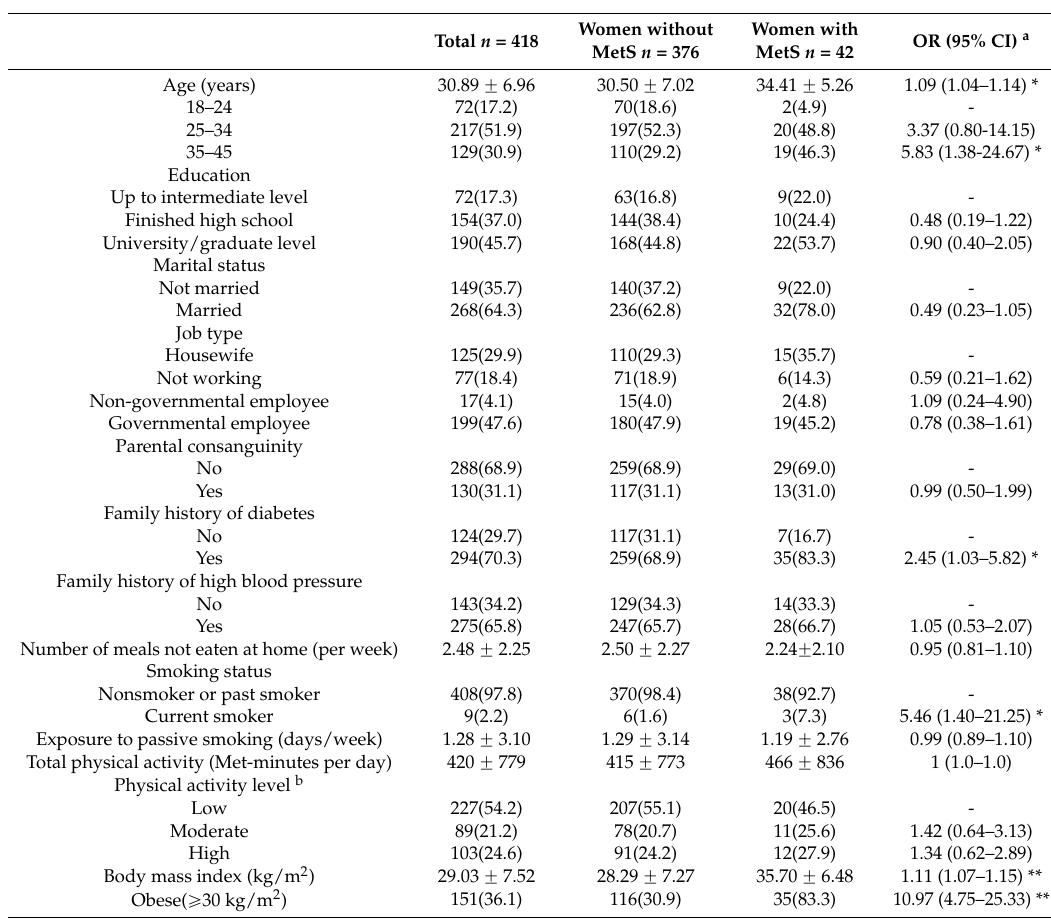
Table 1. Socio-demographics, lifestyle and anthropometric characteristics of study participants and their association with MetS ( n =